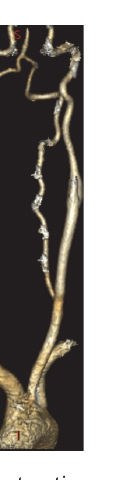
Figure 2: CT angiogram reconstruction of the neck shows no obstruction, dissection, stenosis, or abnormalities.